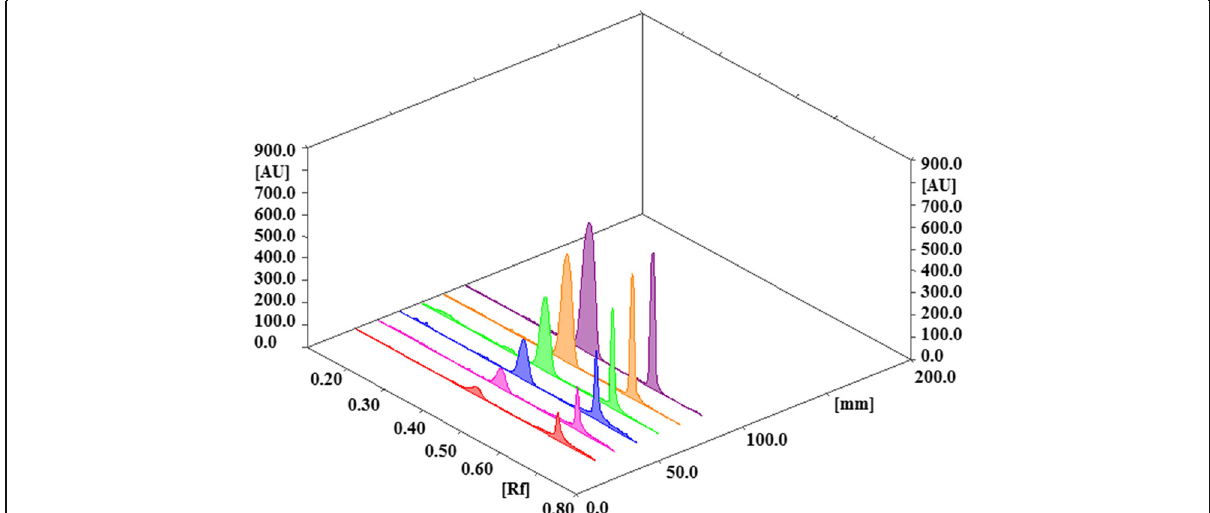
Fig. 3 3D densitogram of SBR (R f = 0.38) in the concentration range of 0.80 – 25.6 μ g/band and LPV (R f = 0.61) in the concentration range of 0.4 – 12.8 μ g/band at 265 nm using toluene: ethanol: ammonia (4:1:0.2, v/v/v) as a developing